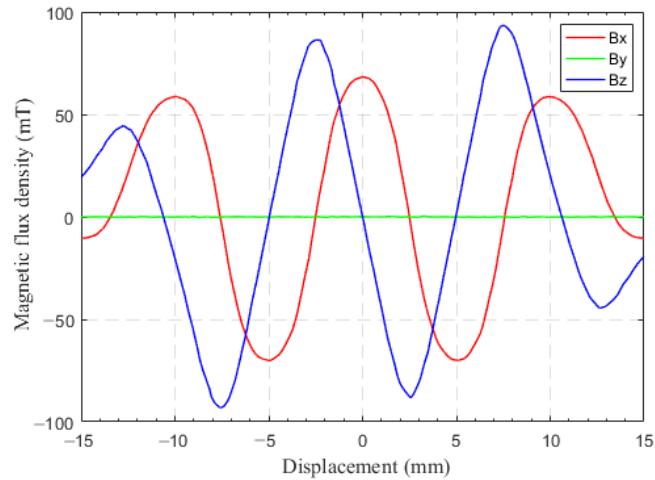
Figure 3. 3D magnetic field of permanent magnet array detected by Hall sensor “A”.